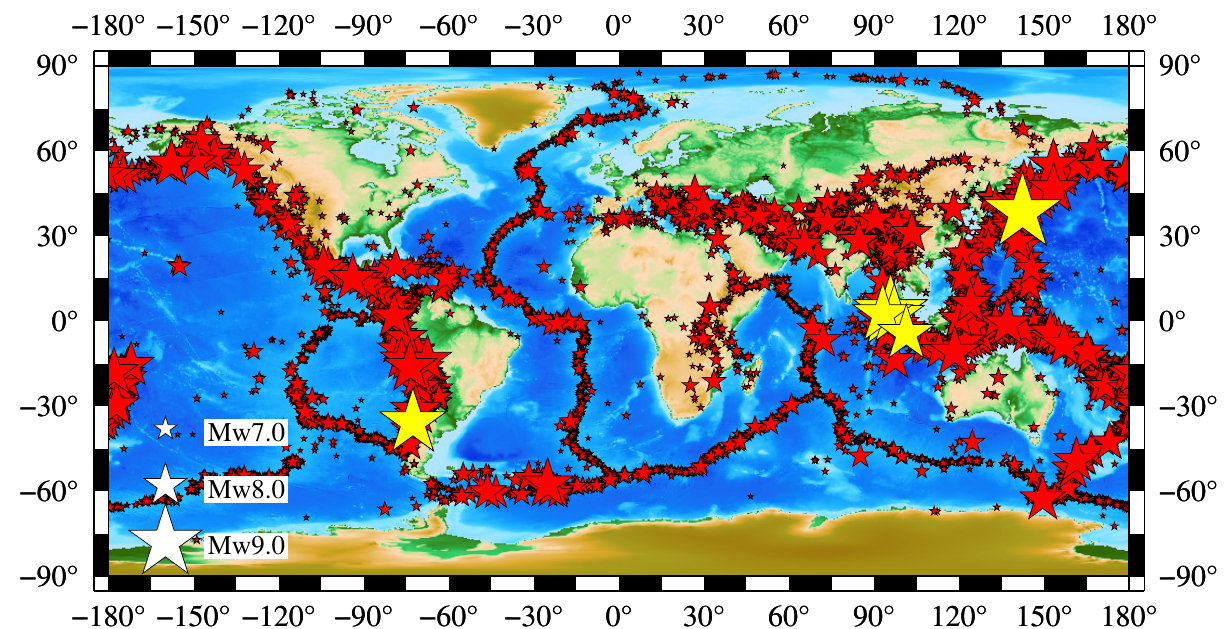
Figure 1. The map shows global seismicity with all EQs of M ≥ 5.0 as reported by GCMT during the period from 1 January 1976 to 31 January 2022 (see References [89,90] and Section 2.1). The EQs with M ≥ 8.5 appear with yellow color, while for M < 8.5 with red color. ETOPO1 Global Relief Model [91] was used to integrate the land topography and ocean bathymetry. This map was made using Generic Mapping Tools